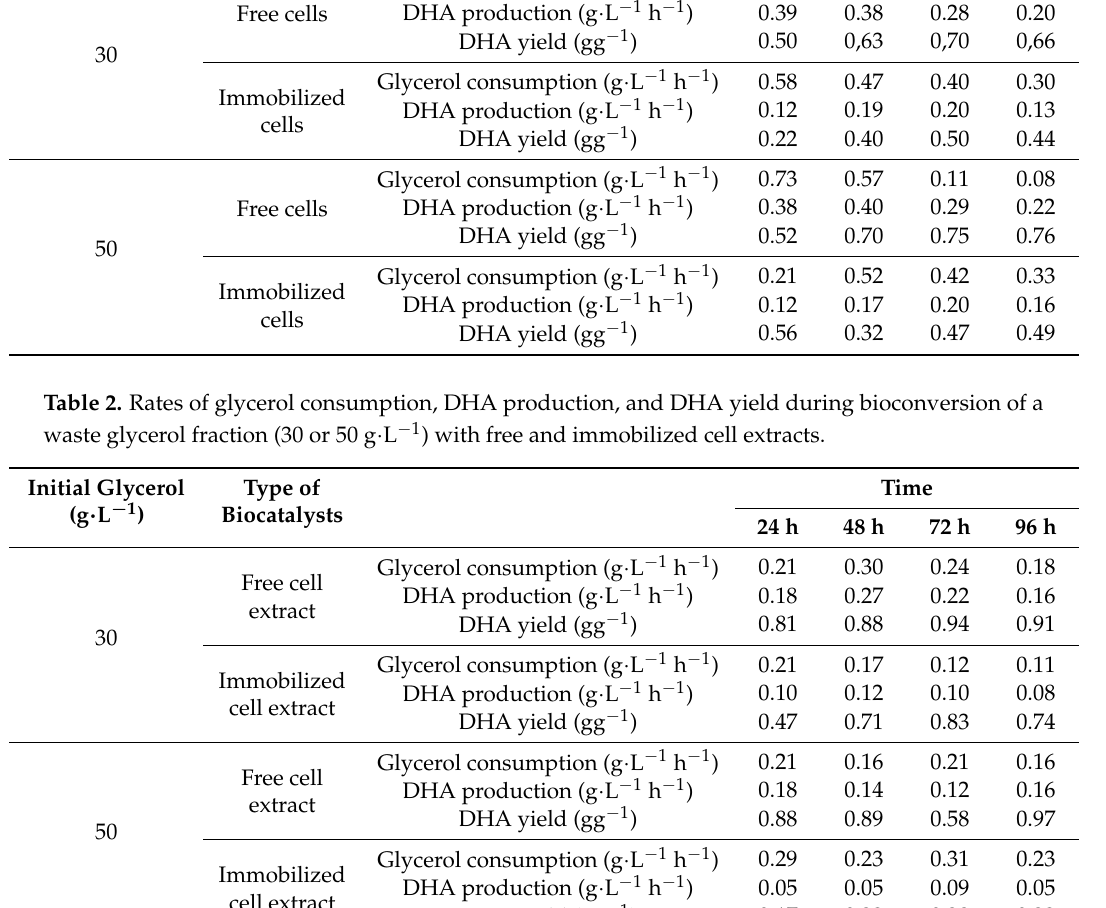
Table 1. Rates of glycerol consumption, DHA productivity, and DHA yield during bioconversion of a waste glycerol fraction (30 or 50 g · L − 1 ) with free and immobilized cells of G. oxydans . Initial Glycerol (g · L − 1 )